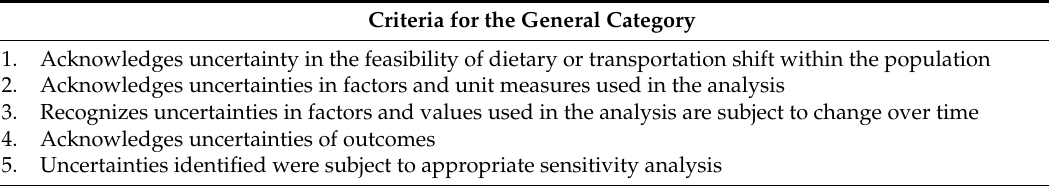
Table 1. Rubric for scoring biases, limitations, and uncertainties. Criteria for the General Category 1.